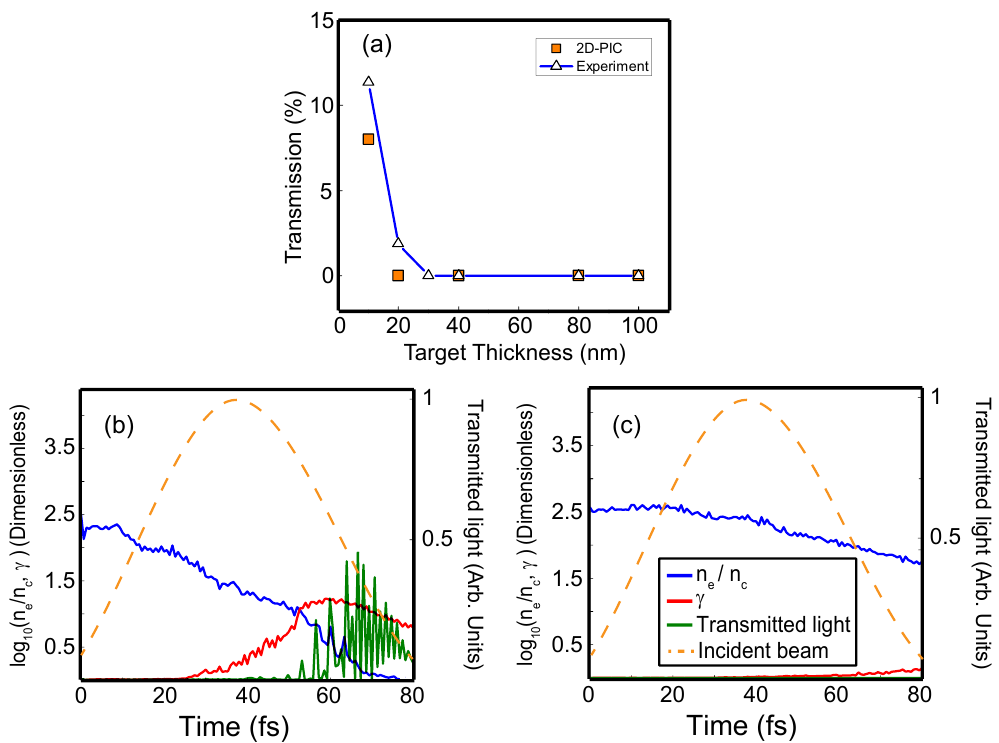
Figure 5. ( a ) Measured percentage of laser energy transmitted through the target foil as a function of target thickness (open triangles), plotted together with values from the PIC simulations at corresponding thicknesses (filled squares); ( b ) PIC simulation results for the peak electron density normalized to the critical density along the Z = 0 axis (blue), electron Lorentz factor (red) and transmitted laser light (green), as a function of time, for l = 10 nm. The incident laser pulse temporal profile is shown by the dashed line; ( c ) Same for l = 40